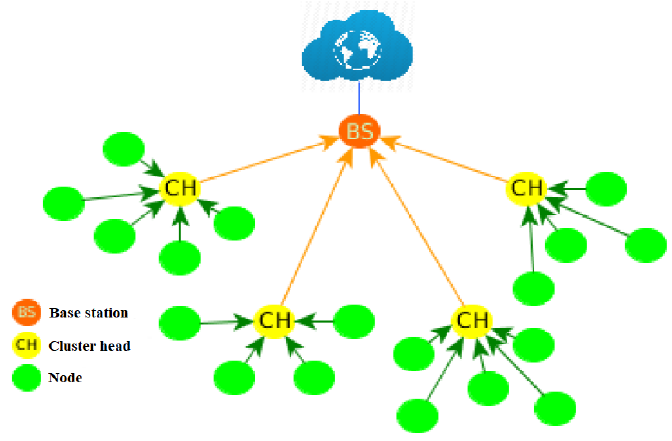
Figure 1. LEACH protocol topology.